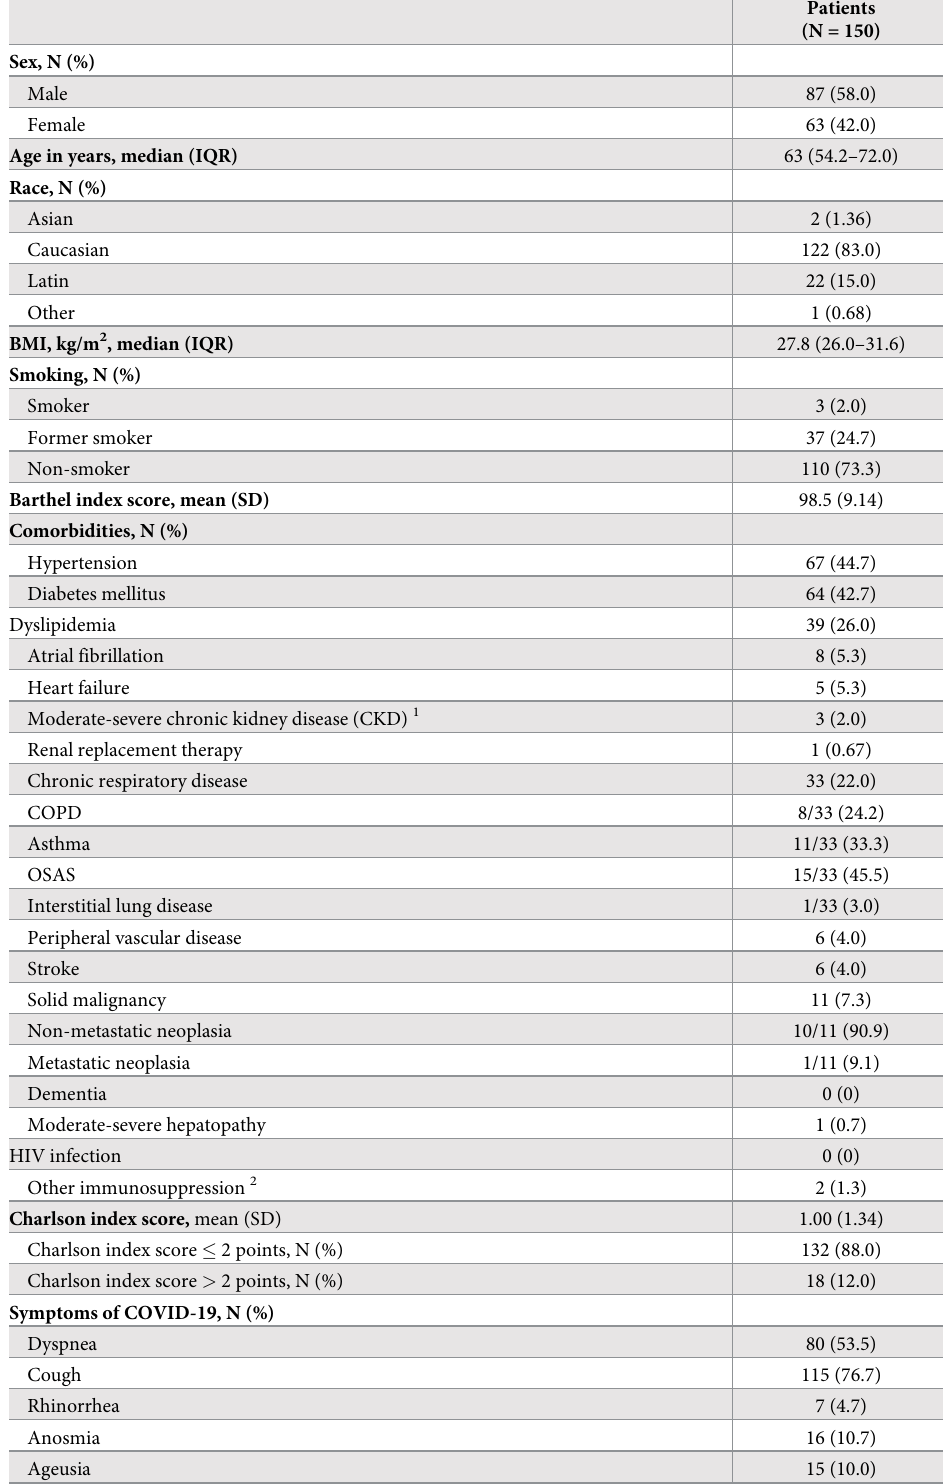
Table 1. Demographic and clinical characteristics, laboratory findings, treatments, and complications in patients during acute COVID-19